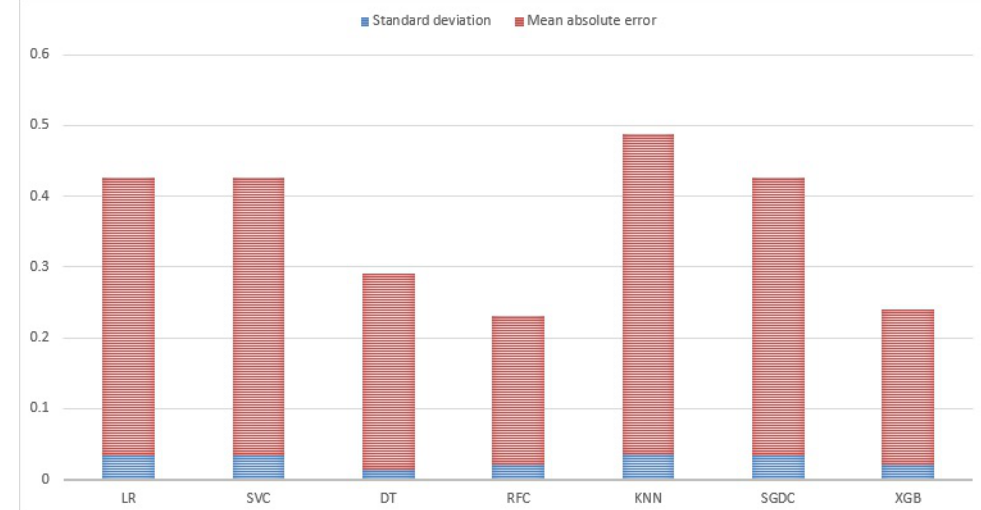
Figure 5. Standard deviation and mean absolute error of models.